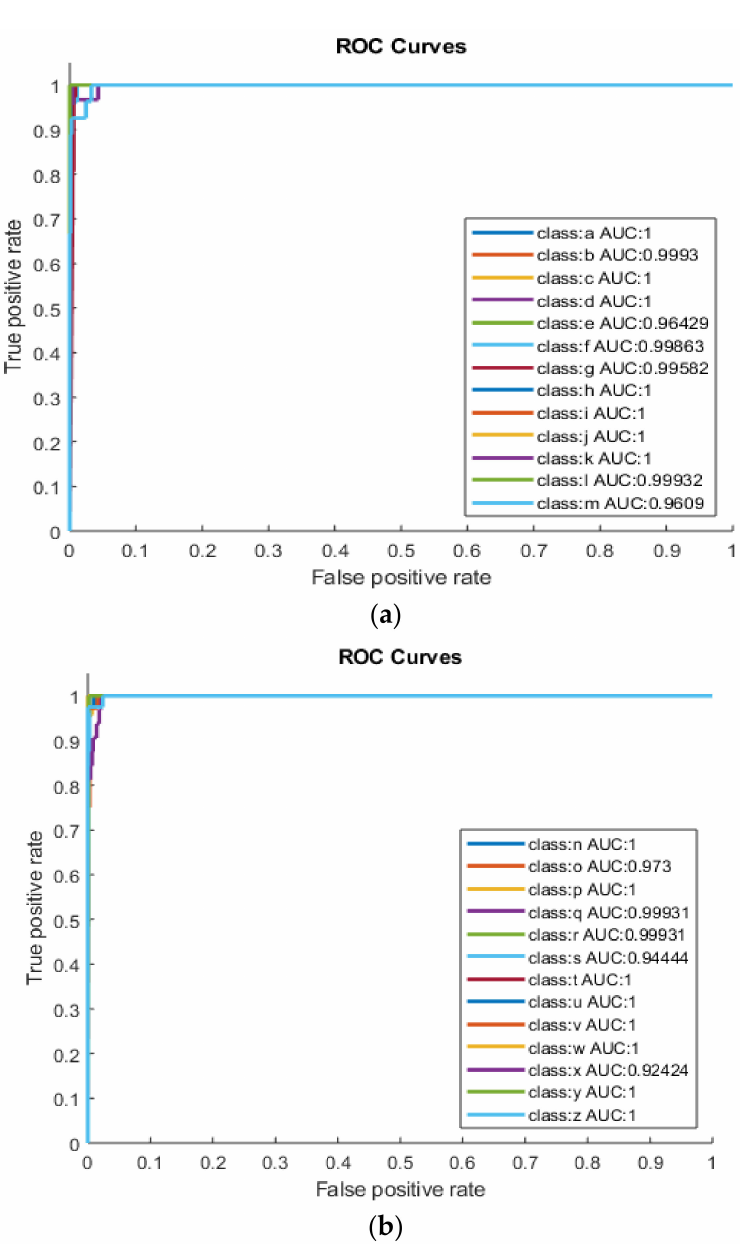
Figure 5. ( a )Category-1 (a–m) using SVM and ( b ) category-2 (n–z) using SVM. For comparison purposes, we used PCA-based feature extraction methods, Random Forest and the Simple neural network. Among all the results, classifiers used with the RICA- based feature extraction method showed the best performances. Using Random Forest with five n_folds, a max_depth of 10 and Trees value of 10, the mean accuracy achieved was 75.61%. The results revealed by implementing the Sequential model using activation functions ReLu and Softmax, a batch size of five and 2000 epochs accuracy achieved was 93.51%, with a loss of 0.1736. With PCA feature extraction, the accuracy achieved for SVM, KNN and DT were 86.32%, 75.40% and 70.02%, respectively. All performances of SVM were better than DT and KNN using both feature extraction methods. SVM achieved a TA of (99.86%), TPR of (98.23%), TNR of (99.91%), PPV of (97.94%), NPV of (99.94%), FPR of (0.0009%) and F1-Score = 0.980. Followed by DT, which shows the TA (99.79%), TPR (96.91%), TNR (99.89%), PPV (97.22%), NPV (99.89%), FPR (0.0011) and F1-score (0.970), followed by KNN with TA (99.50%), TPR (95.32%), TNR (99.70%), PPV (93.70%), NPV (99.79%), FPR (0.0030%) and F1-Score (0.939), as shown in Table